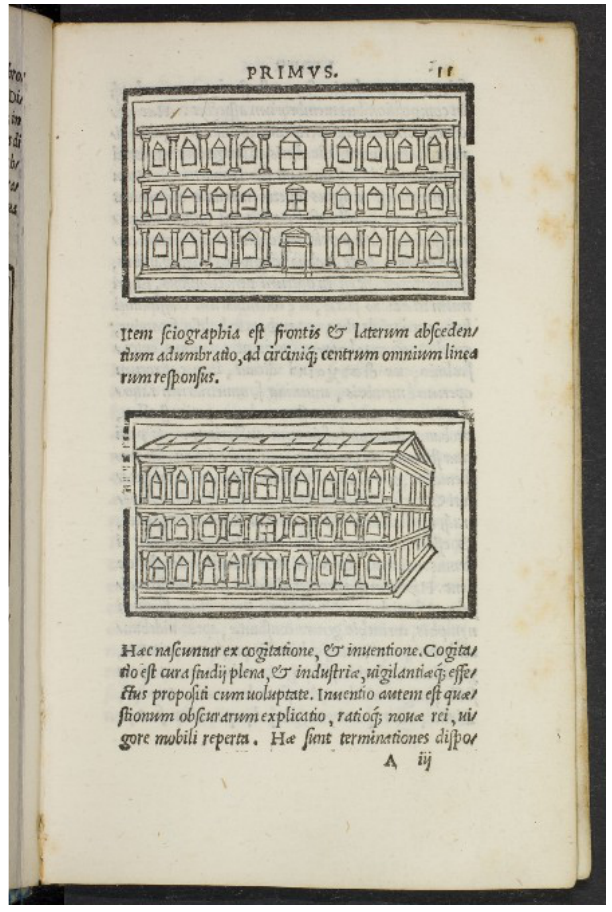
Figure 1. Orthographia (top) and Sciographia (Bottom) from Fra’ Giovanni Giocondo, M. Vitruvii de architectu , Third Edition (Florence, 1522) 11 recto.